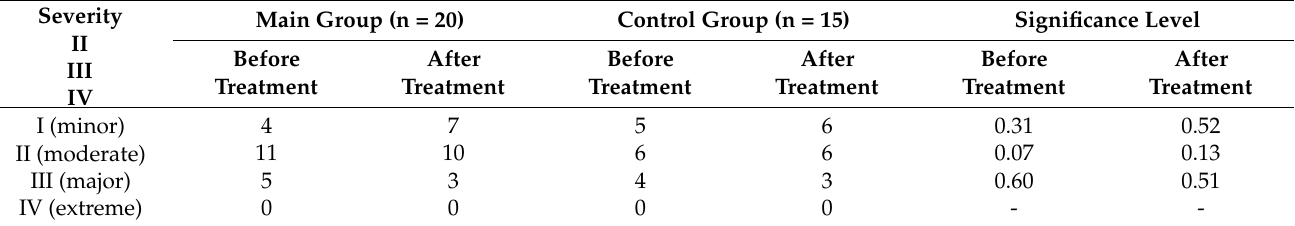
Table 3. Patient distribution according to peripheral atherosclerosis severity during treatment.